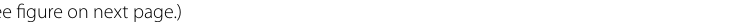
figure on next Fig. 3 Stable regions in iRBDRP and PDRP overlap. Stable voxels (90% confidence interval not straddling zero after bootstrap resampling) of iRBDRP and PDRP are overlaid on T1 MRI template. A Stable, relatively hypermetabolic regions of PDRP (green) and iRBDRP (red). B Stable, relatively hypometabolic regions of PDRP (purple) and iRBDRP (blue). L left. Coordinates in axial (Z) and sagittal (X) planes are in Montreal Neurologic = Institute standard space. From: (Meles et al.